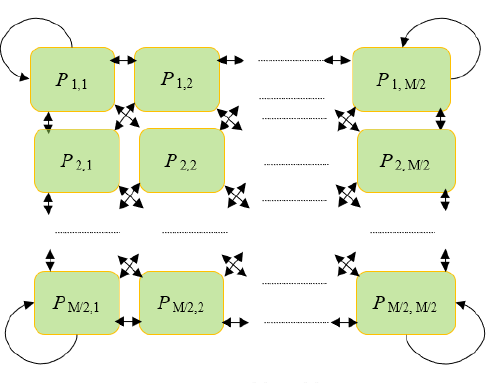
Figure 8. Architecture of M